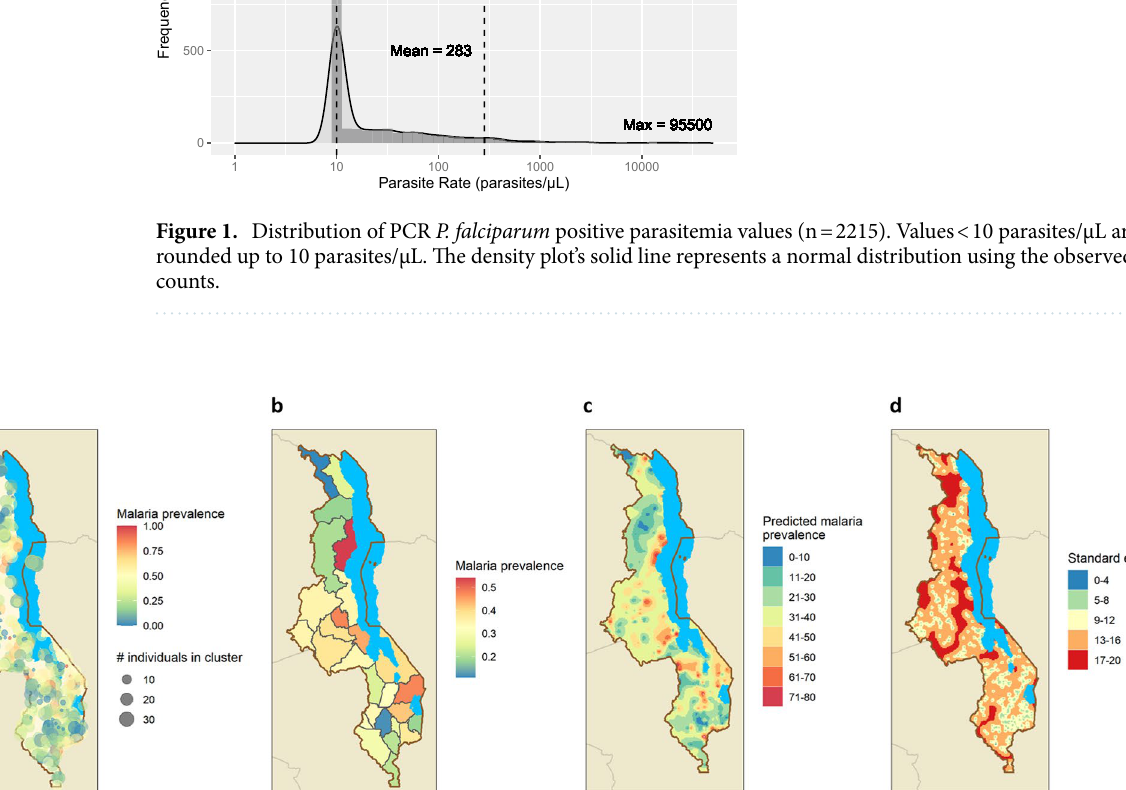
population. Community-level household bed net coverage and the community-level proportion who slept under an LLIN were not protective against P. falciparum infection in the general population. Sensitivity analyses defining malaria positivity as PCR amplification which crossed the threshold line below C T values of 37 and 38 found similar relationships between covariates and P. falciparum prevalence in bivariate and multivariate analyses (Supplementary Tables 5–8).